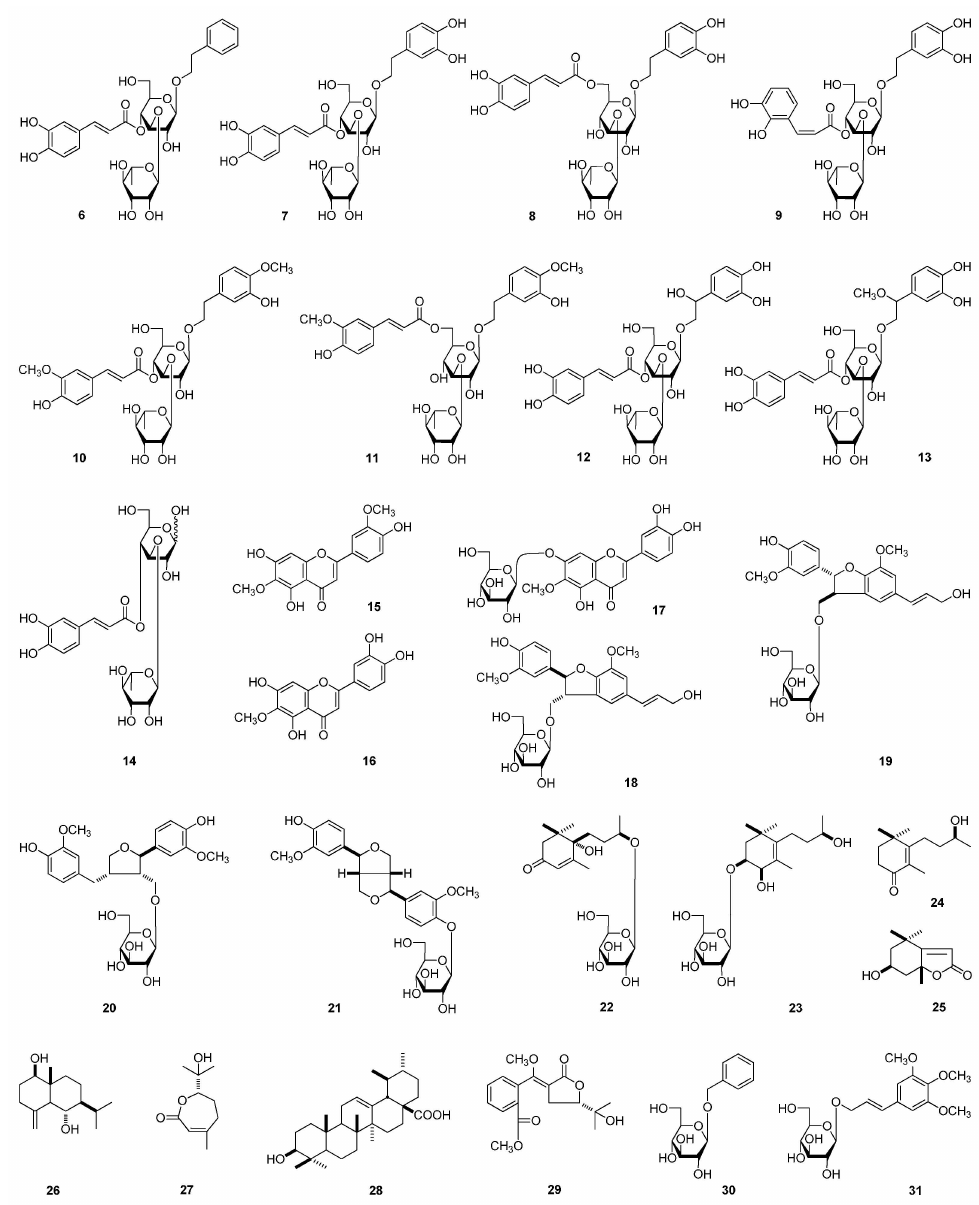
Figure 2. The known compounds ( 6 – 31 ) obtained from L. triphylla .